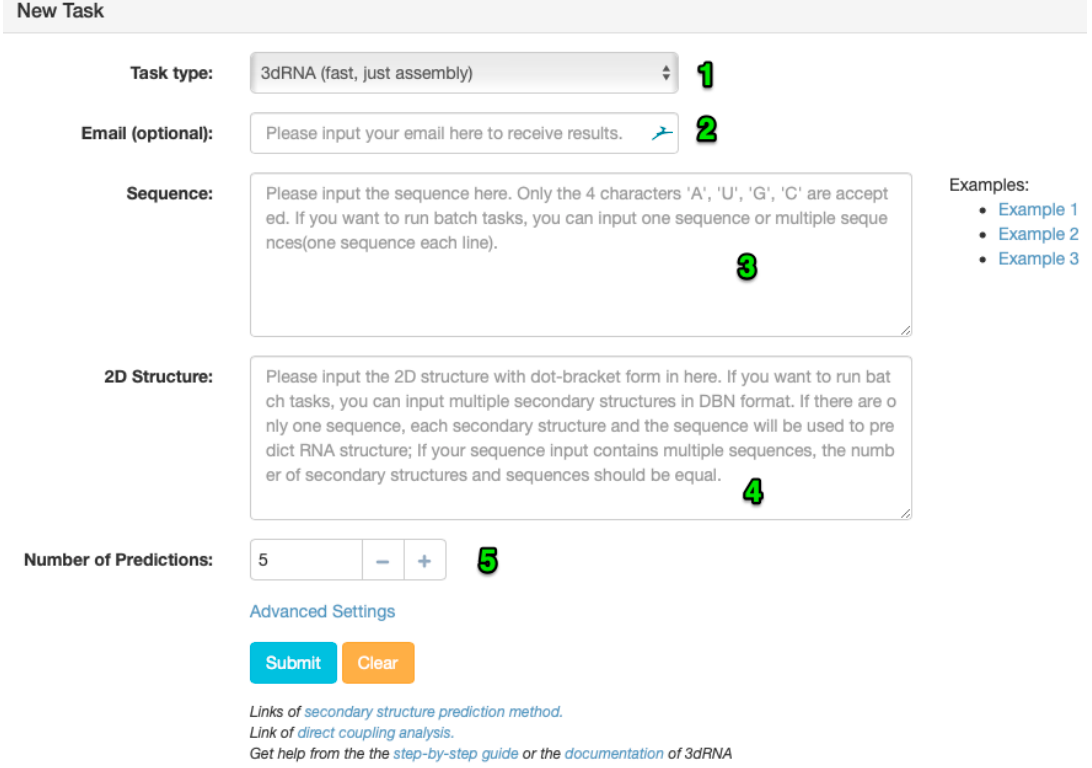
Figure 3. The main page of the 3dRNA web server. The fields labelled with a number in the figure are as follows: (1) “Task Type” field is used to select one of the task types in the following section. (2) The email you want to use to get notification after the job is finished; (3) A “Sequence” field is a required field, which is the sequence of the RNA you want to predict. (4) The “2D structure” field is the corresponding secondary structure for the sequence. (5) The “Number of Predictions” field is used to specify the number of final predictions you want to get.